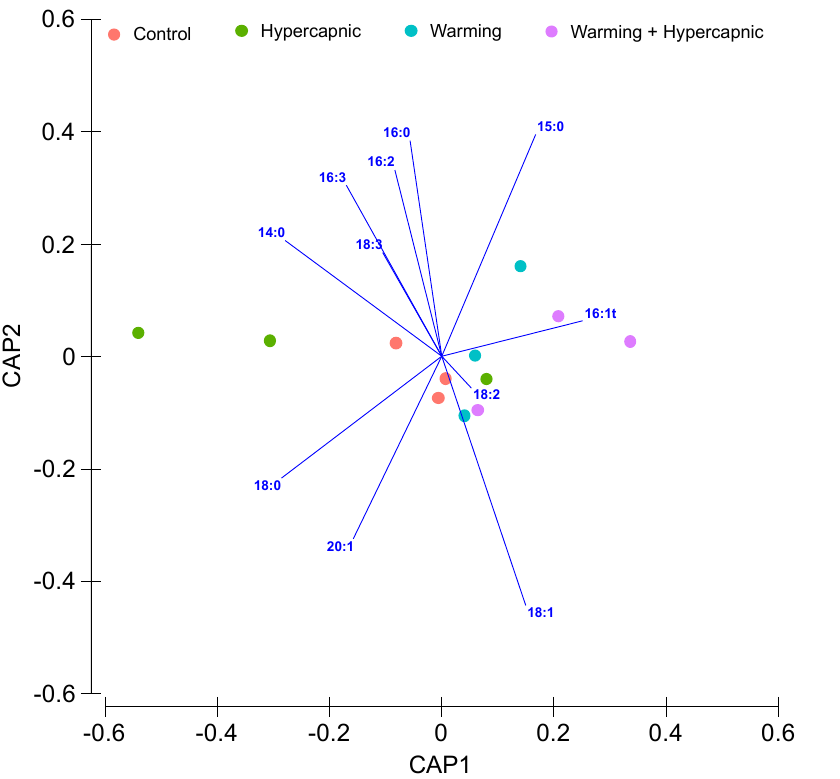
Figure 10. Relative Zostera noltii leaf neutral lipid fatty acid concentration canonical analysis of principal (CAP) components of the samples exposed to control, hypercapnic, warming and combined stress conditions ( n = 3 per treatment).